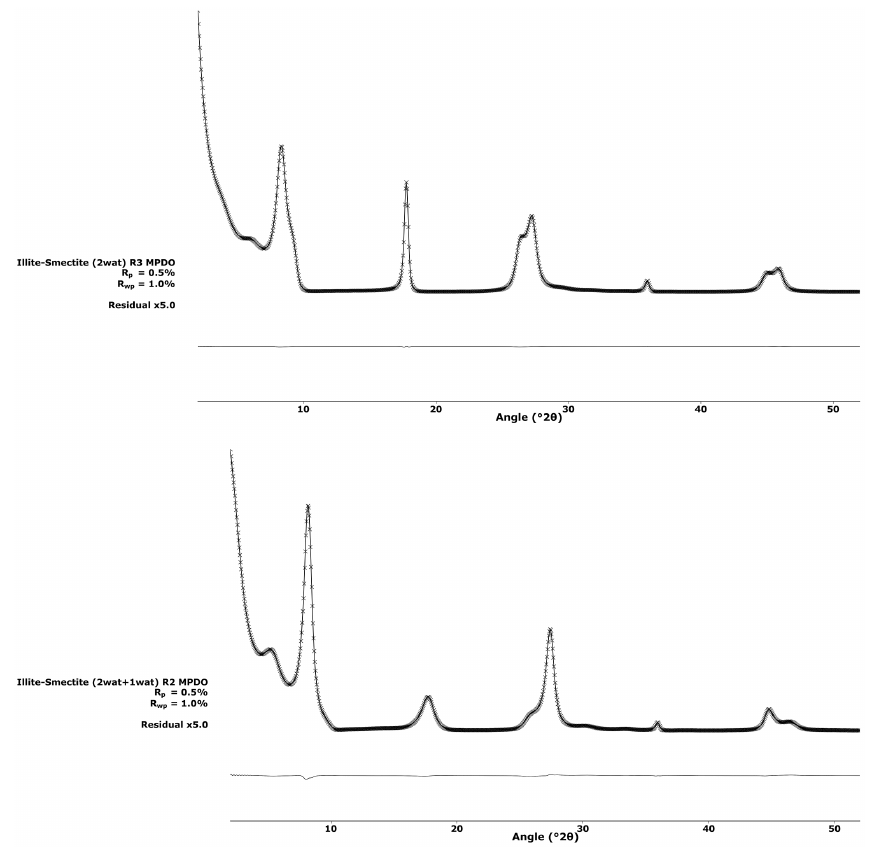
Figure 4. Calculated patterns for illite–smectite (IS) R3 (top) and illite–smectite (ISS) R2 (bottom; both have MPDO), showing nearly identical output for PyXRD (solid line) and Sybilla (crosses). For clarity the residual patterns are scaled to 5 times their original intensity.